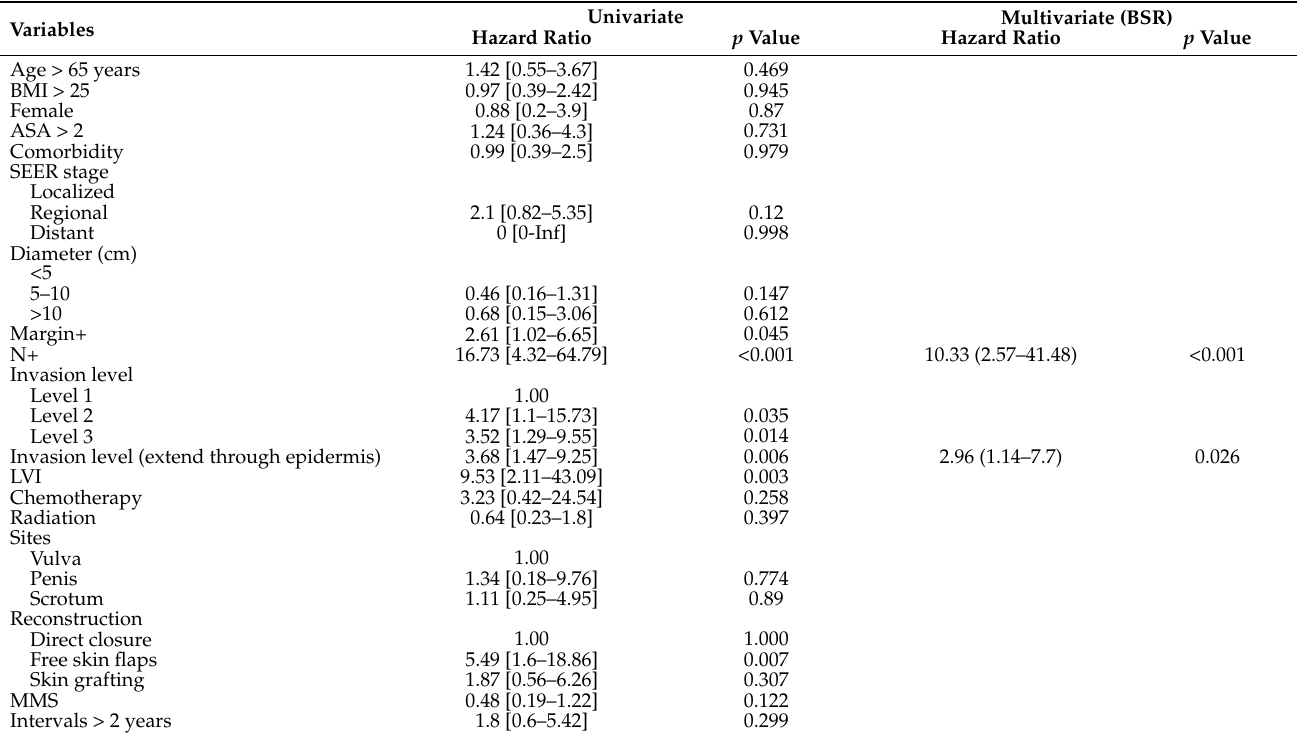
Table 3. Univariate and multivariate (backward stepwise) Cox regression for CSS in